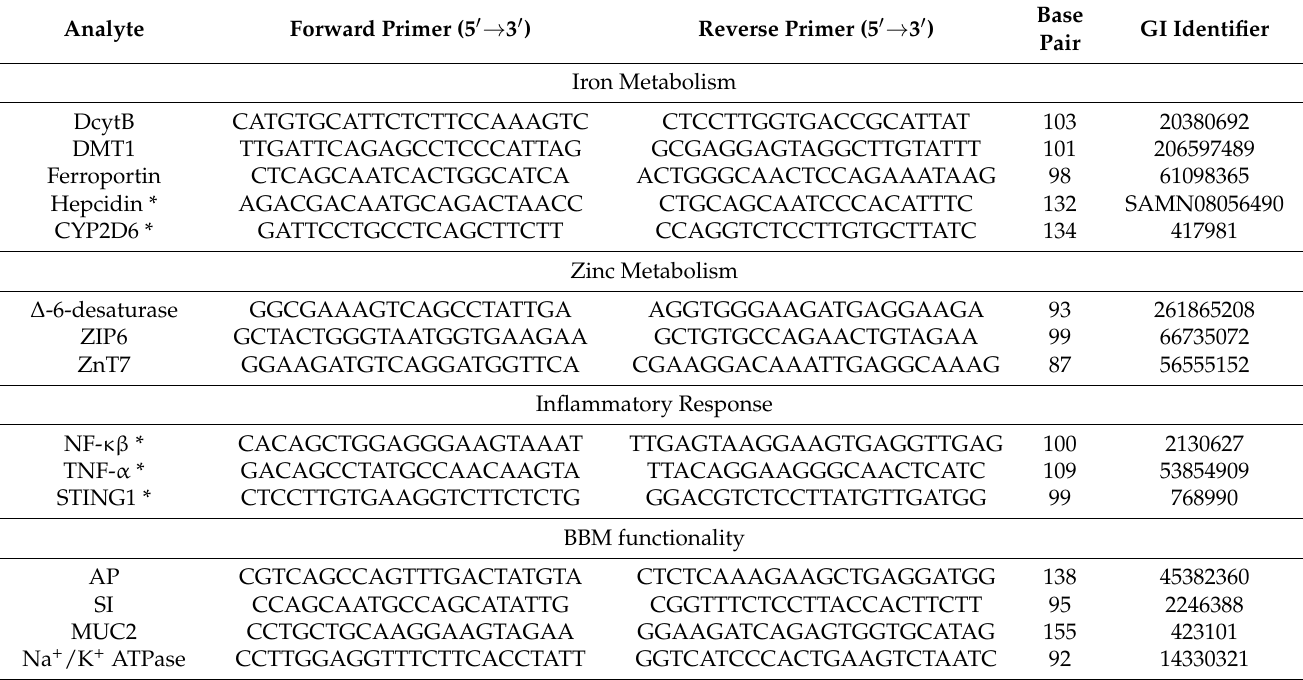
Table 1. DNA sequences of primers used in this